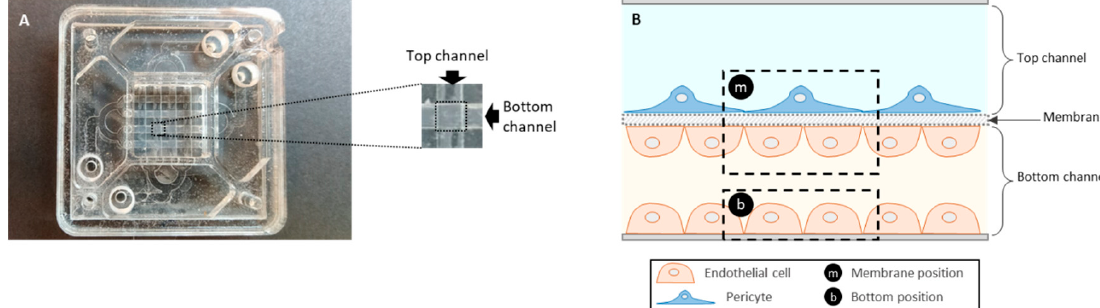
Figure A2. Oxygen monitoring. ( a ) System response; ( b ) Measuring setup.